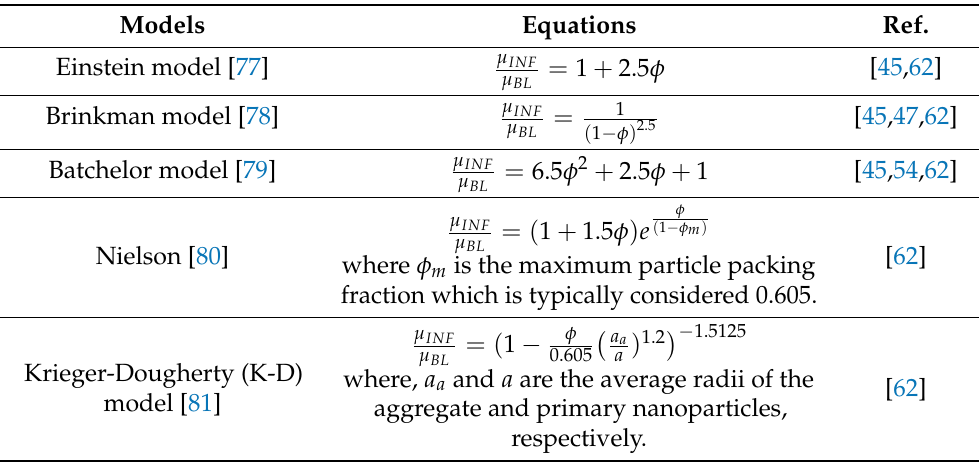
Table 5. Theoretical models of the effective viscosity of ILs-based nanofluids.